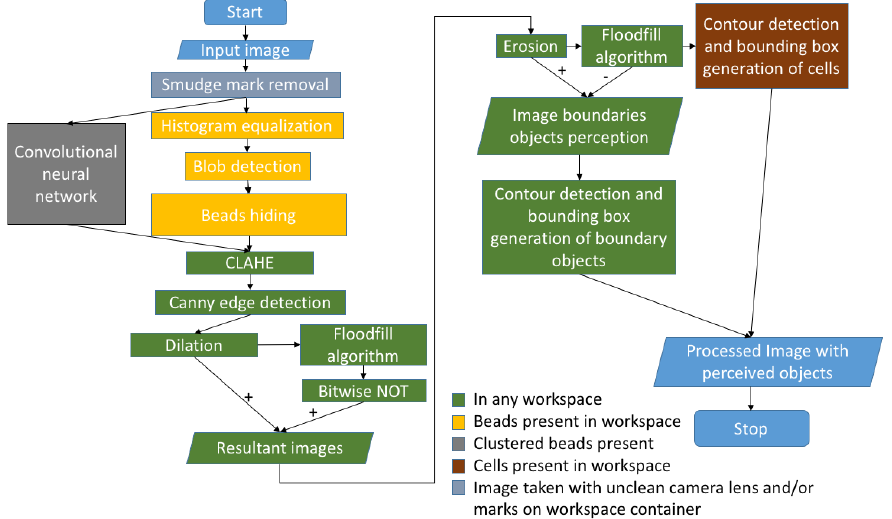
Figure 16. Microscale object perception method flowchart. CLAHE: contrast limited adaptive histogram